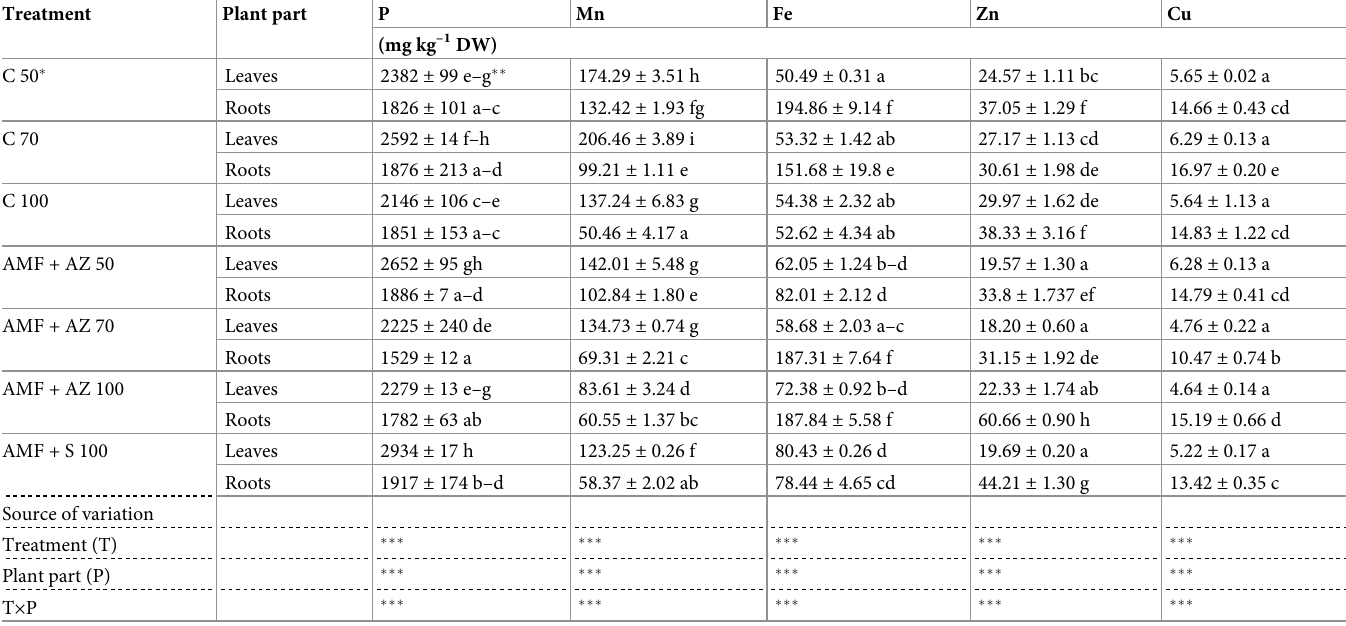
Table 6. Effects of soil microorganisms application to substrates of different organic matter on phosphorus, manganese, iron, zinc, and copper content in leaves and roots of tomato transplants.